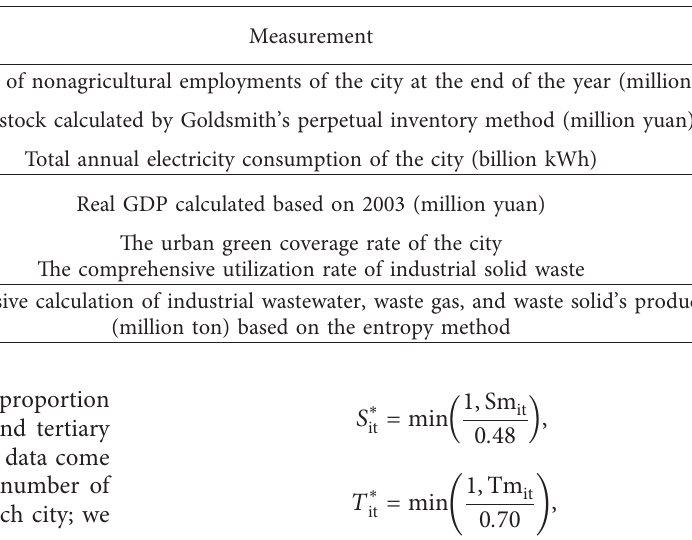
Table 2: The input and output factors of